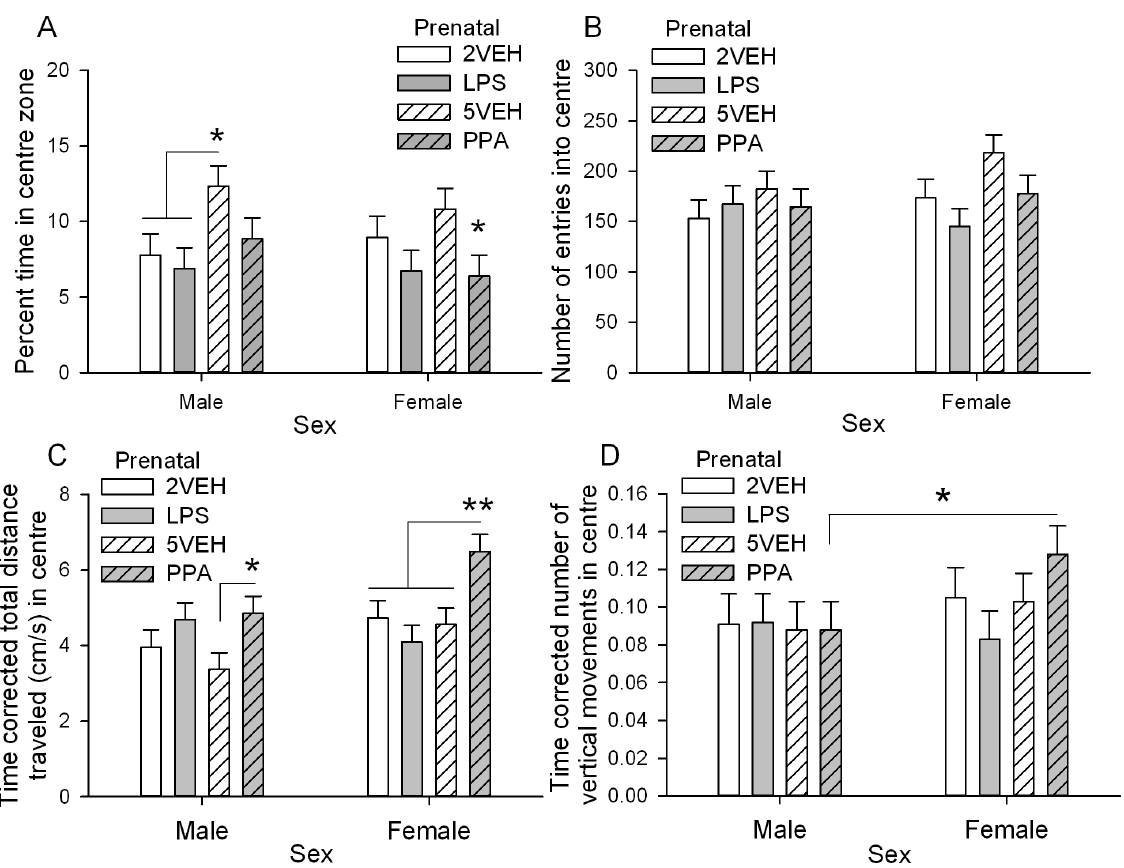
Figure 5. Thigmotaxis measures in a novel open-field (P42) in male and female offspring. Activity measures were time corrected. Females moved significantly more than males. A: Percent time in the centre of the open-field. Animals in the prenatal PPA treated group spent significantly less time in the centre of the open field than the prenatal 5VEH treated group. B: Number of entries into the centre. There were no significant differences in entries into the centre. C: Total distance traveled (cm/s) in the centre. Male and female offspring in the prenatal PPA treated group traveled significantly greater distances than the 5VEH treated control group. D: Number of vertical movements in the centre. Prenatal PPA treated female offspring reared significantly more than prenatal PPA treated male offspring. Error bars represent S.E.M. Refer to Table 1 for group designations and sample sizes. * p , 0.05, ** p , 0.01.